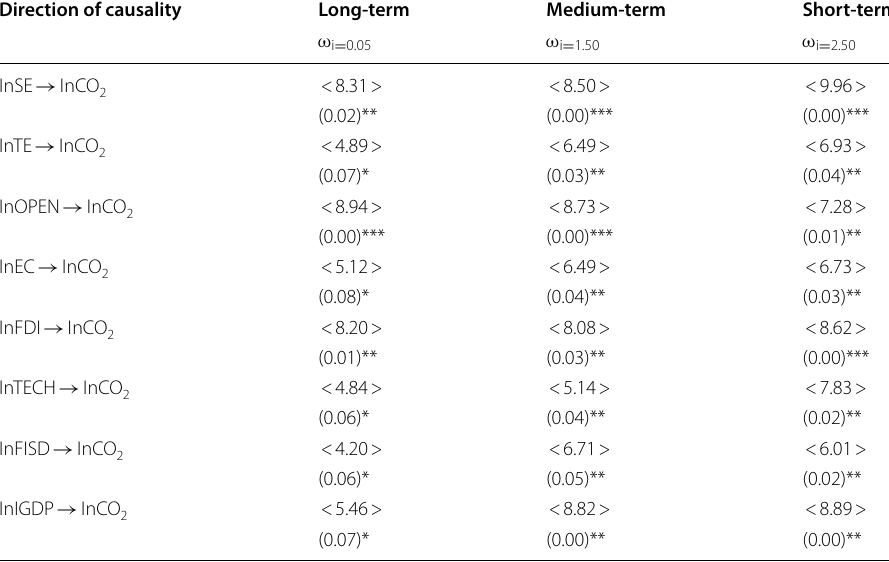
Table 9 Frequency-domain causality